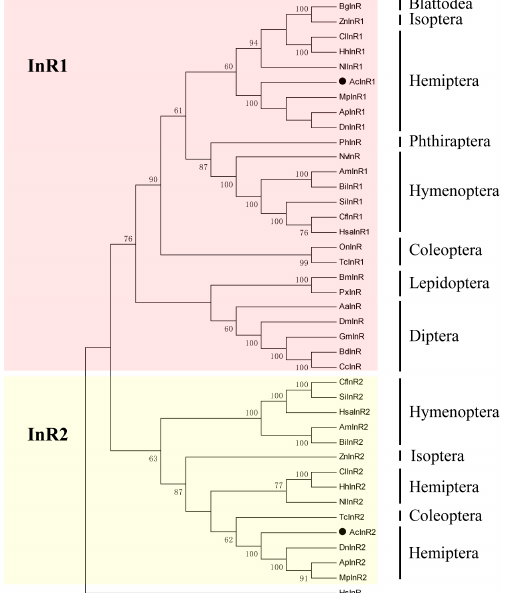
Figure 1. Phylogeny of insect insulin receptors. A phylogenetic tree constructed from amino acid sequences of various insect insulin receptors. The tree was constructed using MEGA 5.05 based on the maximum likelihood (ML) method according to amino acid sequences. Bootstrap support values with 1000 samples are shown on the branches (only those above 50%). Insulin receptors were from Blattella germanica (Bg), Zootermopsis nevadensis (Zn), Climex lectularius (Cl), Halyomorpha halys (Hh), Nilaparvata lugens (Nl), Aphis (Toxoptera) citricidus (Ac), Myzus persicae (Mp), Acyrthosiphon pisum (Ap), Diuraphis noxia (Dn), Pediculus humanus corporis (Ph), Nasonia vitripennis (Nv), Apis mellifera (Am), Onthophague nigriventris (On), Tribolium castaneum (Tc), Bombyx mori (Bm), Plutella xylostella (Px), Aedes aegypti (Aa), Drosophila melanogaster (Dm), Glossina morsitans morsitans (Gm), Bactrocera dorsalis (Bd), Ceratitis capitata (Cc) Homo sapiens